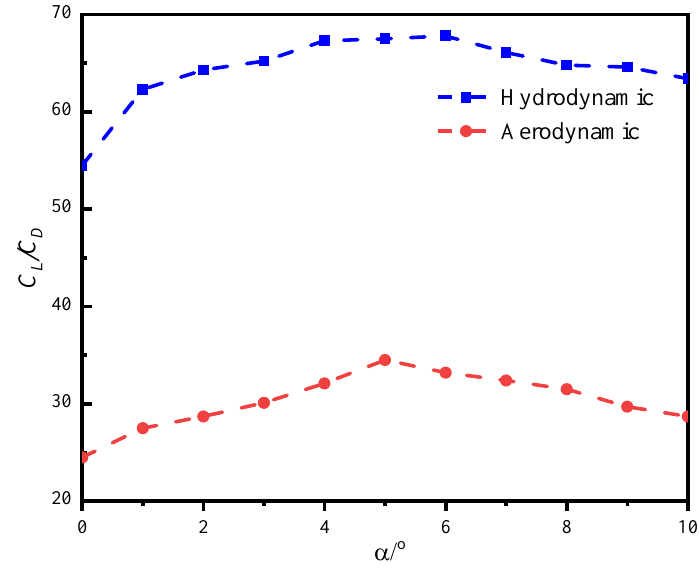
Figure 3. Hydrodynamic and aerodynamic characteristics of seagull airfoil.